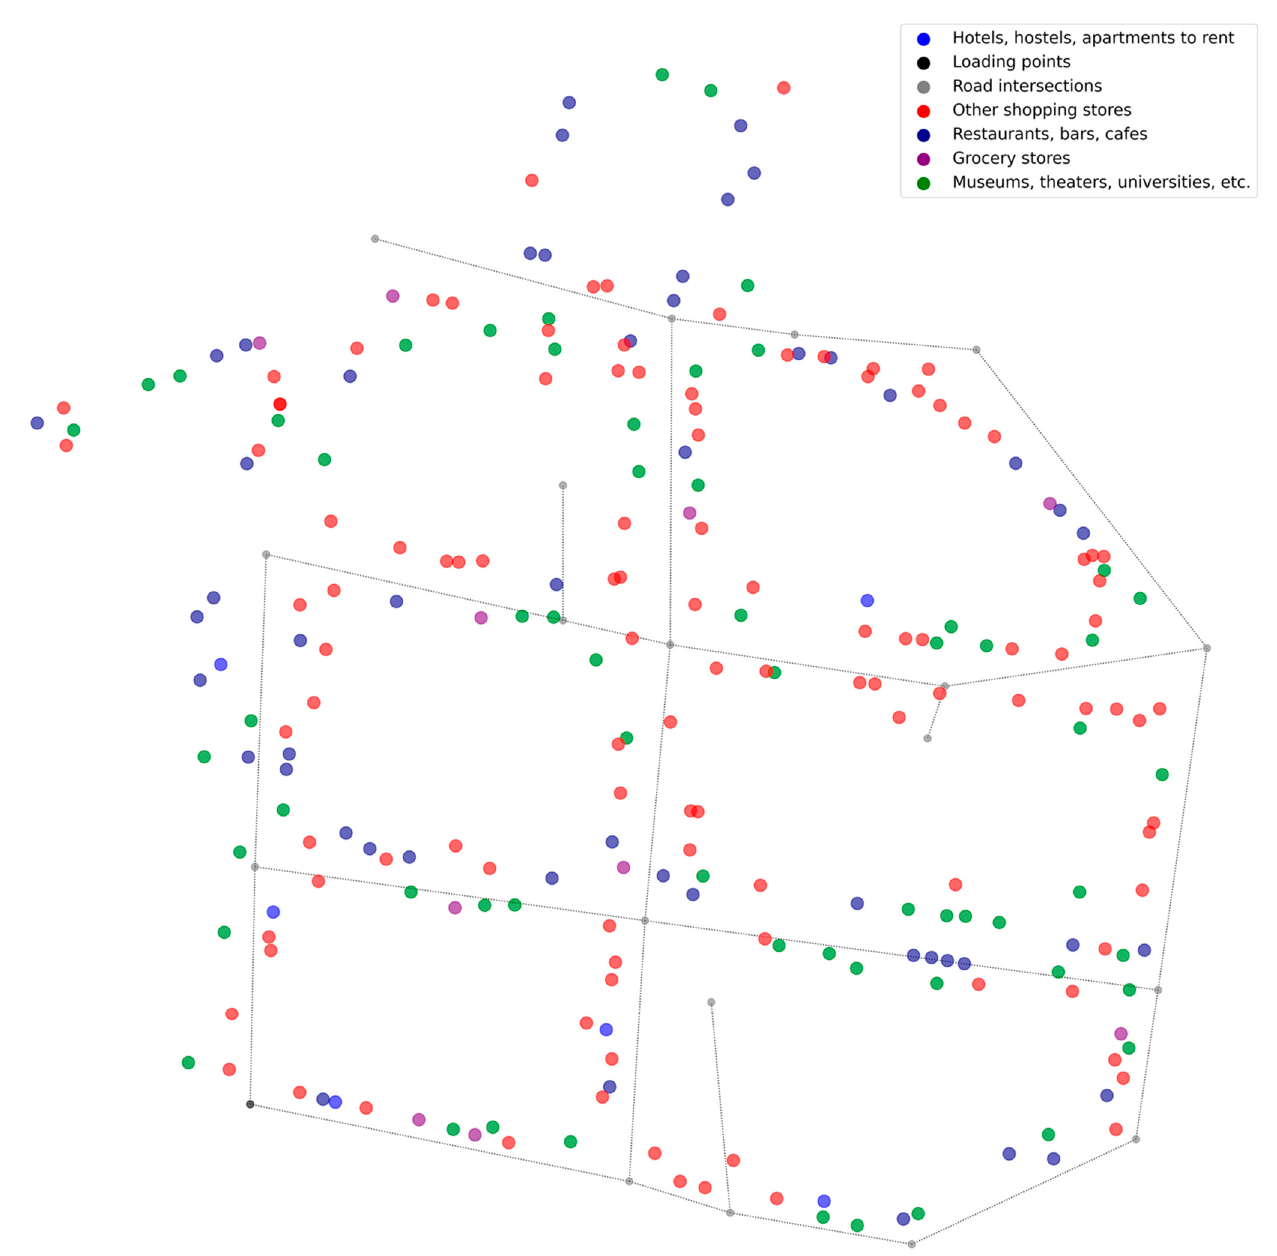
Figure 2. Location of the clients and the road network of the central district of Vitoria-Gasteiz. The structure of potential clients in the studied area of San Sebastian (Old Town district) differs from the demand structure in the Vitoria-Gasteiz central district: the biggest group of clients in San Sebastian constitutes restaurants and cafes (almost half—48.8%). The second place has the group of non-grocery stores (28.1), whereas other types of clients have less than 10% part in number: 7.3% for hotels and hostels, 6.6% for grocery stores, and 9.2% for all other types of businesses. As in the case of Vitoria-Gasteiz, commercial objects are located evenly along the streets, and the availability of the roads is good (see Figure